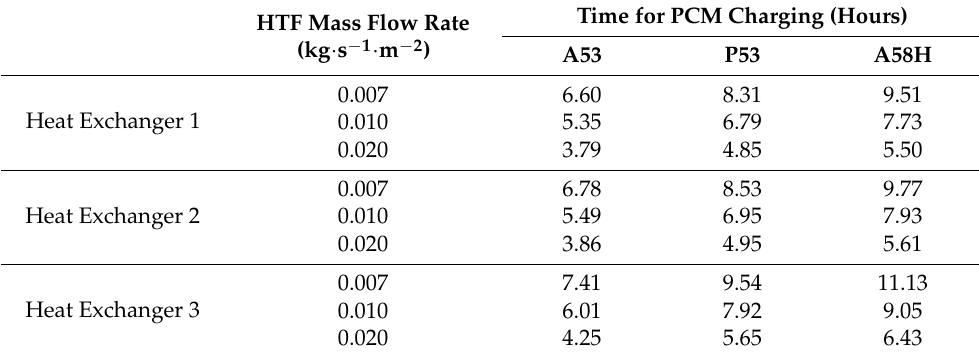
Table A2. Time for charging of A53, P53, and A58H for three different HTF mass flow rates for each selected HE.